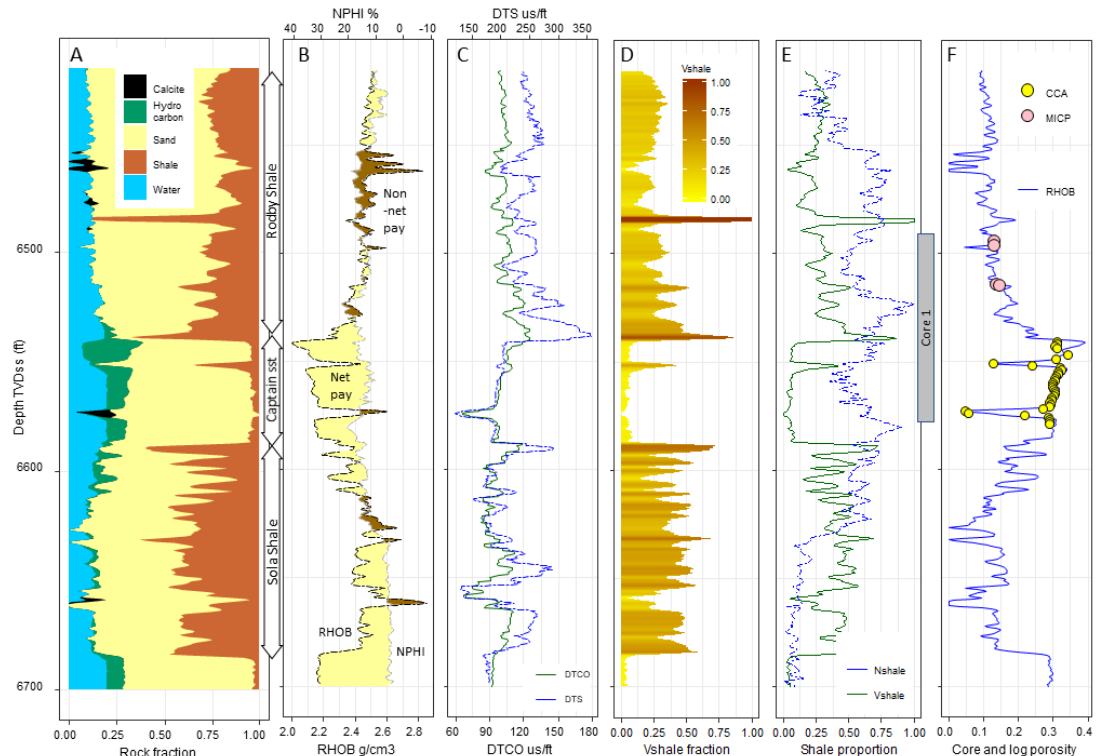
Figure 3. Wireline log raw and interpreted data from well 14 / 26a-7A from the Lower Cretaceous Acorn Storage Site. Diagrams (and in Figures 4–7) prepared using R-studio-ggplot2 software [15]. ( A ) Interpreted lithology and fluid saturation diagram showing the Sola Shale, overlain by the Captain Sandstone, which is overlain by the top-seal of the Rodby Shale. In this well, the Rodby Shale contains much non-shale material and has the lowest porosity in calcite-cemented layers (e.g., 6470–6480 ft). The pre-production petroleum column extended up to beneath the Rodby Shale. ( B ) Neutron-density crossover diagram confirming that the Rodby Shale has intermediate properties (largely non-net reservoir but crossover area remaining narrow). ( C ) Sonic log data; compressional sonic (DTCO) and the compressional shear log (DTS). The higher ratio of DTS to DTCO in the Rodby Shale, and